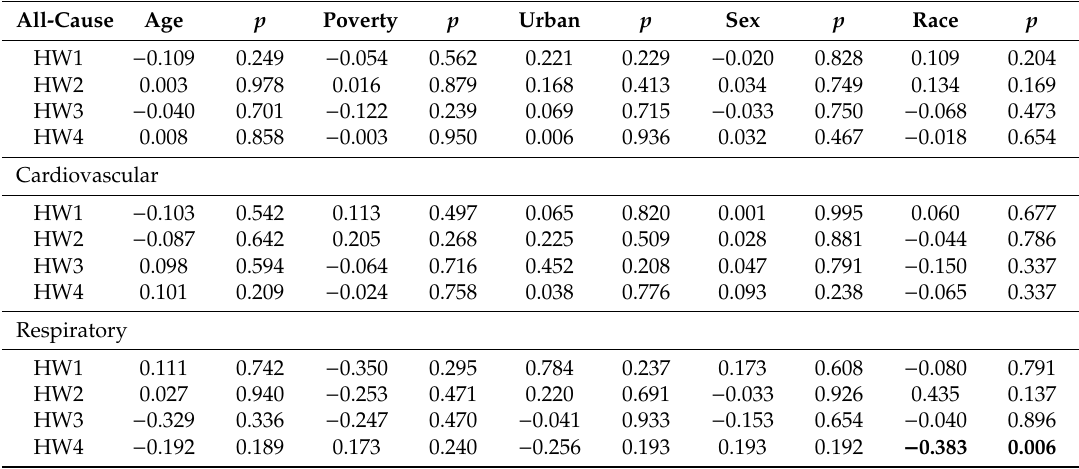
Table 4. Interactions of heatwave days with age group, income level, urbanicity, sex, and